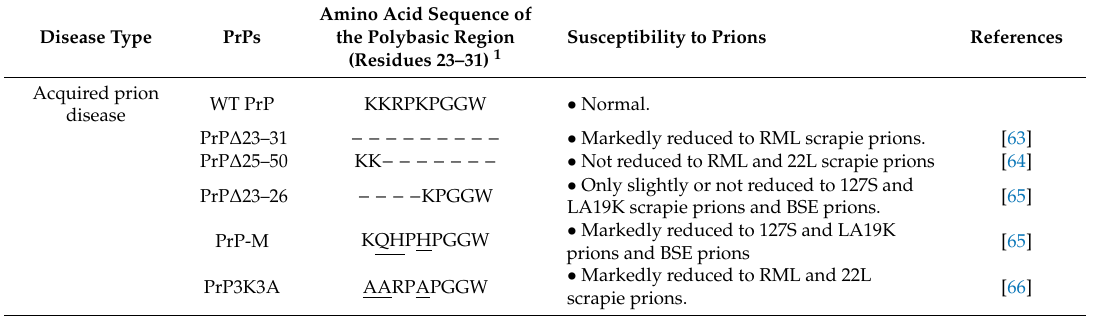
Table 1. E ff ects of various mutations in the polybasic region of PrP C on acquired prion diseases. Disease